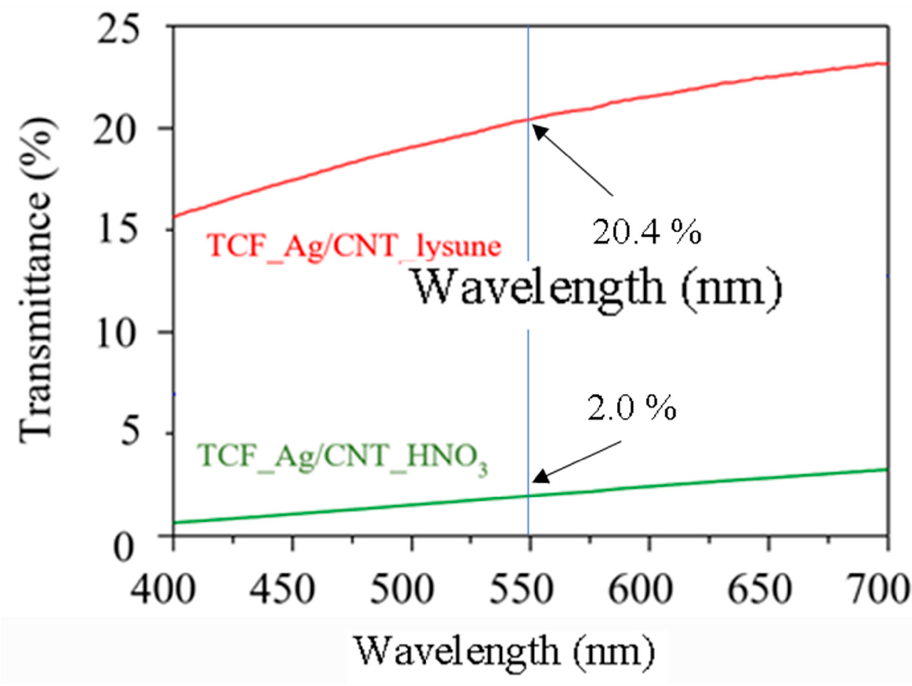
Figure 8. Variation of the optical transmittance of AgNP/MWCNT films with the wavelength.